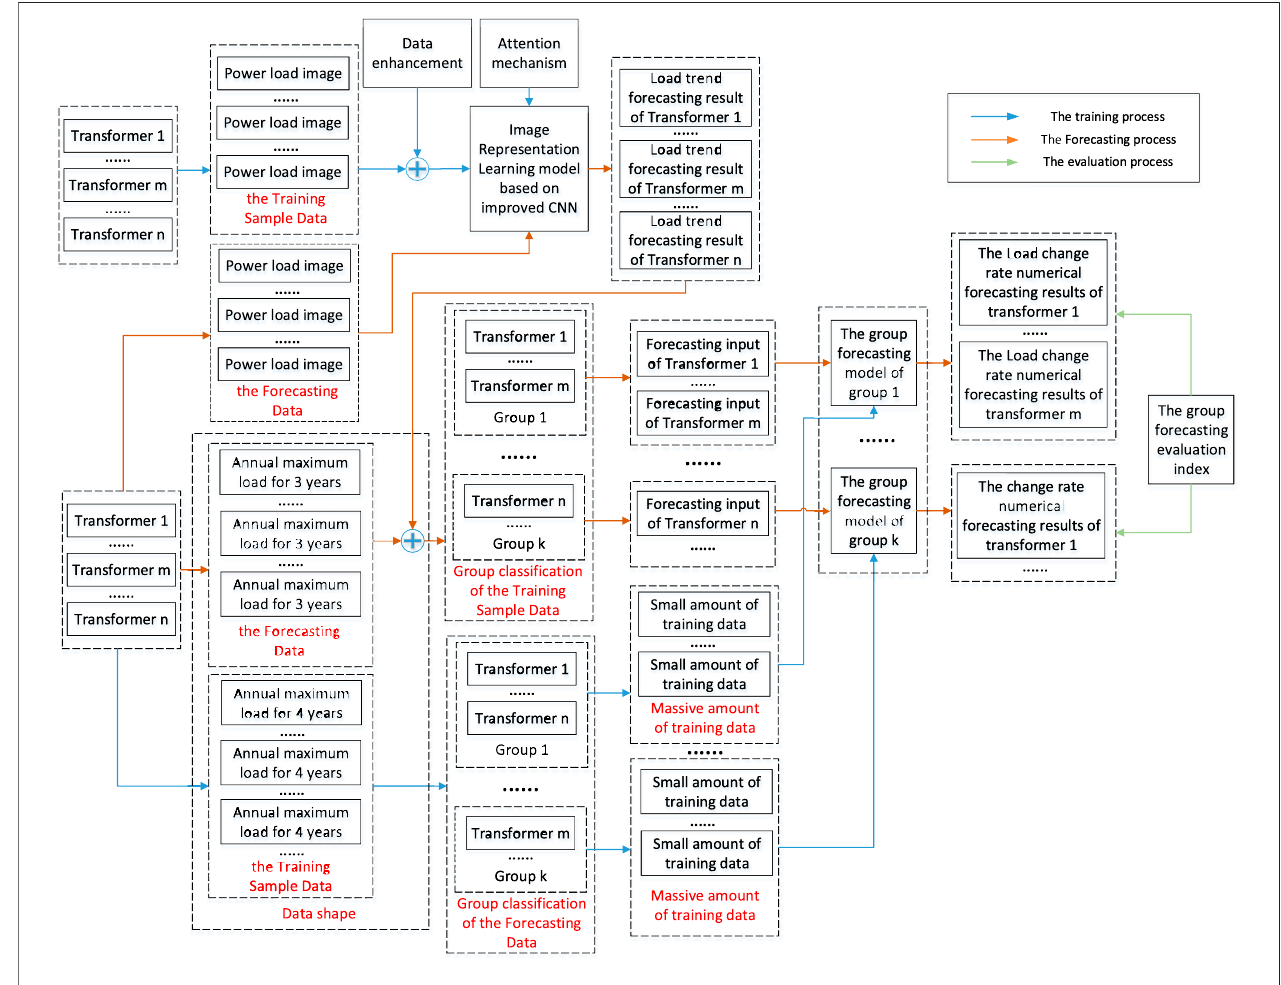
FIGURE 5 | The proposed forecasting